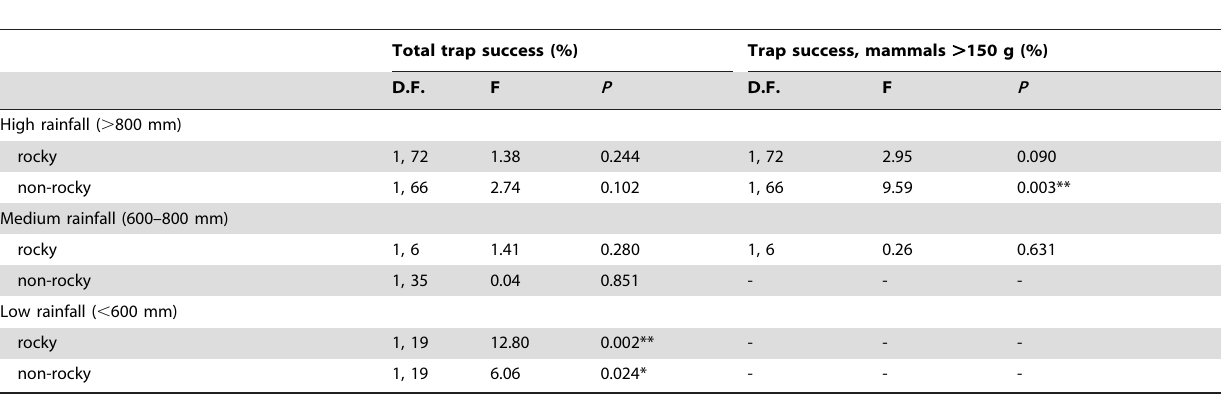
Table 3. Regressions of total trap success for all mammals and for mammals . 150 g of the Kimberley with rainfall preceding the year of survey for different rainfall zones and savanna habitats (rocky and non-rocky).